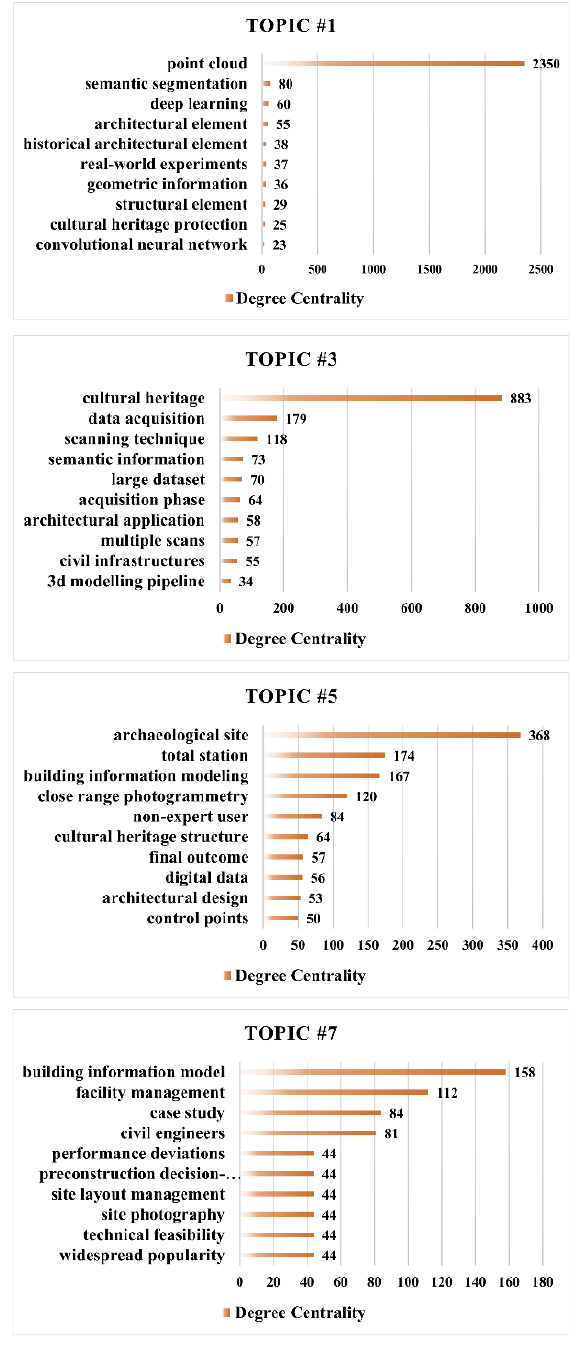
Figure 5. The representative terms of the top 16 clusters. As shown in Figure 5, the topic number aligns with the cluster number. Topic #0 was retrieved from the largest and latest Cluster #0, which includes 208 articles. The cluster was labeled as “historic building information”. The average research year is 2018 . The representative terms in this cluster include “ terrestrial laser scanning ” , “ bim platform ” , “ hbim ” , “ architectural structure ” , and “ parametric object ” , revealing that 3D point cloud